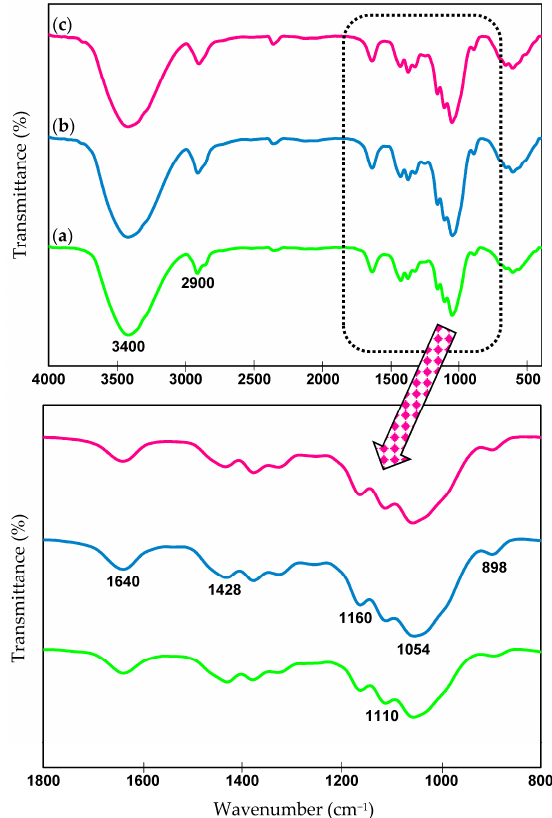
Figure 3. Fourier Transform Infrared (FTIR) spectra of: ( a ) Native cellulose; and CNC isolated via ( b ) H 2 SO 4 ; and ( c ) Cr(NO 3 ) 3 catalyst.